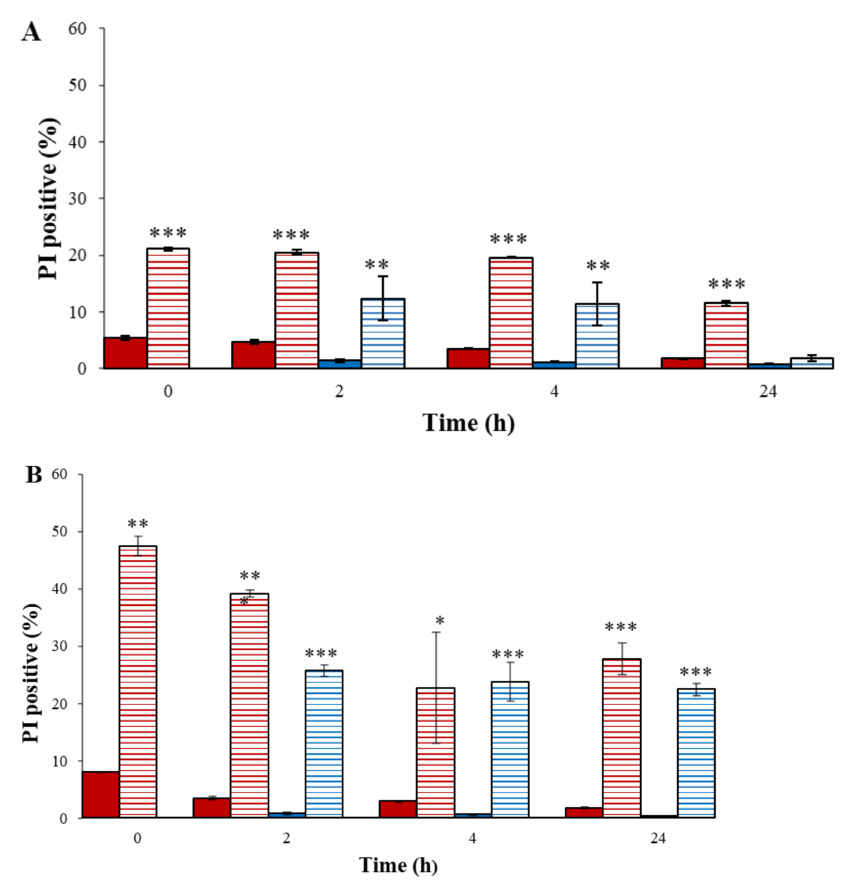
Figure 4. FCM analysis of A. tumefaciens membrane permeability as a function of plasma corona discharge exposure for 30 s. ( A ) and 45 s. ( B ). Nontreated A. tumefaciens in PBS ( ) (0–24 h); plasma-treated A. tumefaciens in PBS (0–24 h) ( ); nontreated A. tumefaciens in LB (2–24 h) ( ); and plasma-treated A. tumefaciens in LB (2–24 h) ( ). Results are mean SD of four independent experiments; p -value significance is presented by t -test of treatment compared to control: * p < 0.05, ** p < 0.001, *** p <